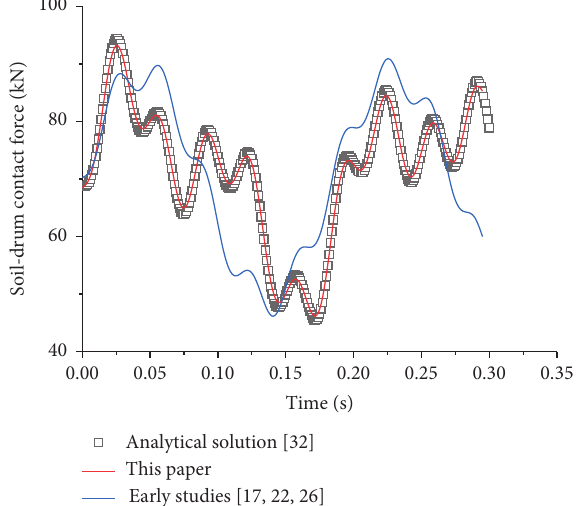
Figure 10: Results of the contact force between the drum and soil.